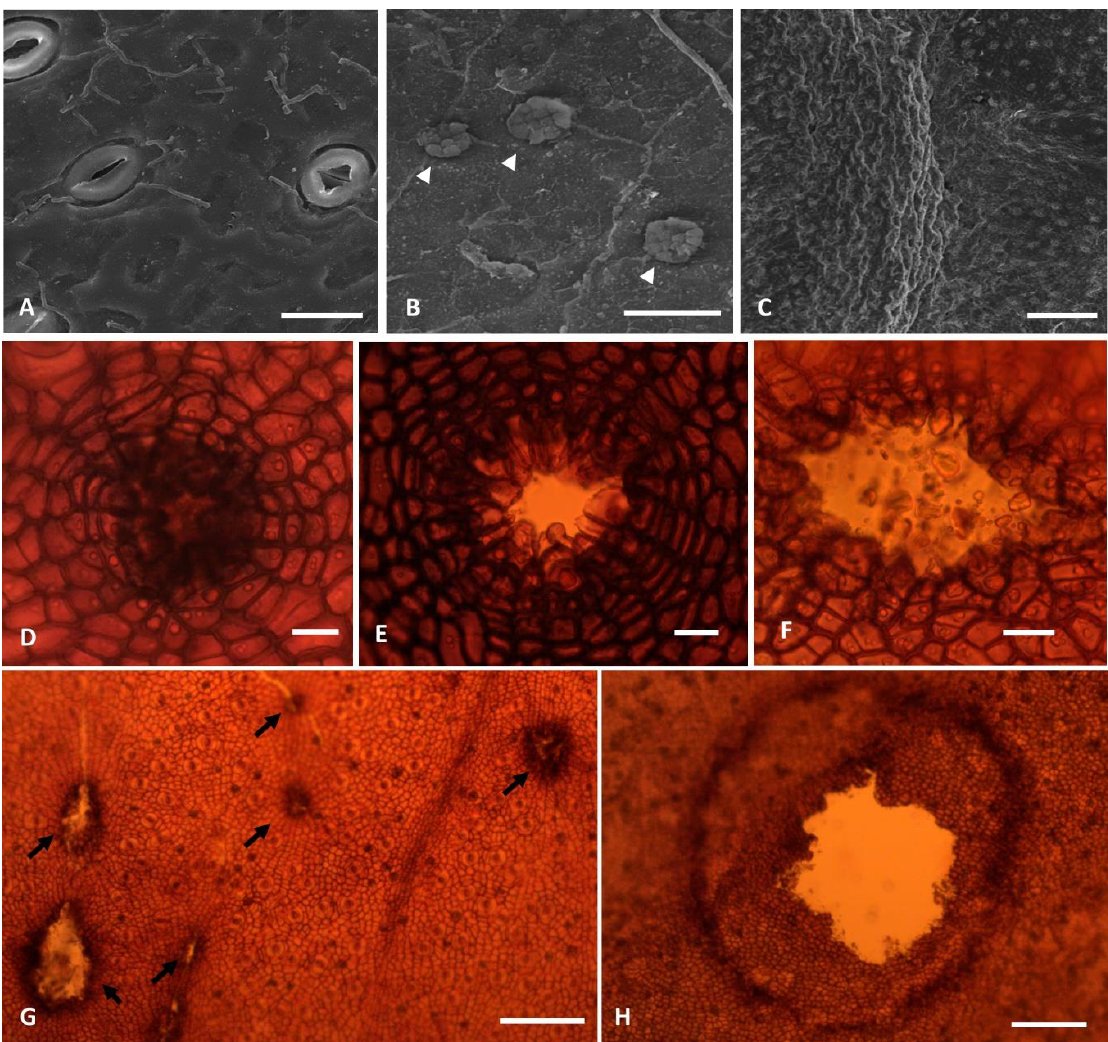
Figure 2. C. fluminensis. Epidermis of non-galled leaves ( A , B ) and galled leaves ( C – H ) of male individuals. ( A – C ) Scanning electron microscopy. ( A ) Abaxial surface showing stomata and straight cuticle with smooth to finely warty layers. ( B ) Cork warts (arrowhead) from the adaxial surface. ( C ) Abaxial surface of the gall region. Note the rough surface, with thick crusts, due to mesophyll hypertrophy. Stomata were abundant next to galls. ( D – F ) Different stages of development of the cork-warts. ( G ) Leaf epidermis of galls. Note the cork-warts in each gall. ( H ) Exit channel. Note the degenerating cells forming a circle around it, which isolates the degeneration of epidermis from the remaining cells. Bars: ( A , B ) = 20 µm; ( C ) = 200 µm; ( D – F ) = 20 µm; ( G ) = 200 µm; ( H ) = 100 µm.